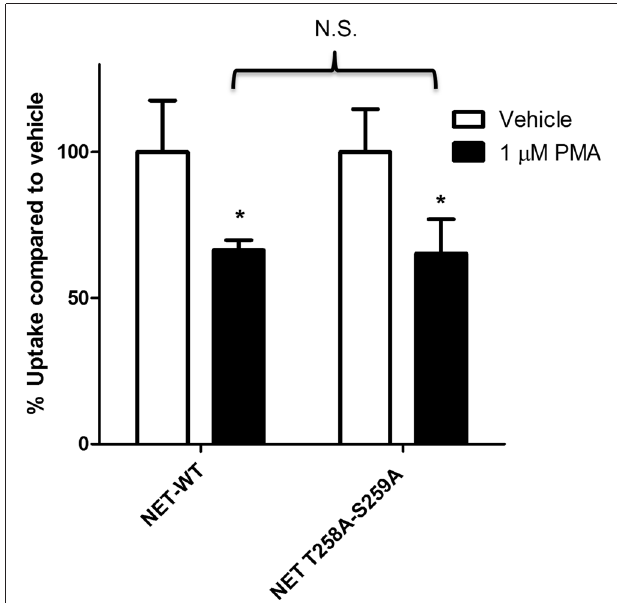
FIGURE 1 | Protein kinase C (PKC)-mediated down regulation of norepinephrine transporter (NET) activity in PC12 cells is not dependent on phosphorylation of residues 258 and 259. Naïve PC12 cells were transiently transfected for 48 h with cDNAs for WT-NET or T258A/S259A-NET. Radiolabeled uptake was measured following 30 min incubation with PKC activator phorbol 12-myristate 13-acetate (PMA; 1 µ M) subtracting mock-transfected cells. All experiments were performed in triplicate in three independent experiments. Both cDNAs were significantly affected by PKC activation ( ∗ p < 0.05) but no significant difference (N.S.) in the magnitude of the PKC-mediated downregulation of uptake was observed between the two cDNAs (two-way ANOVA with Bonferroni post hoc analysis).